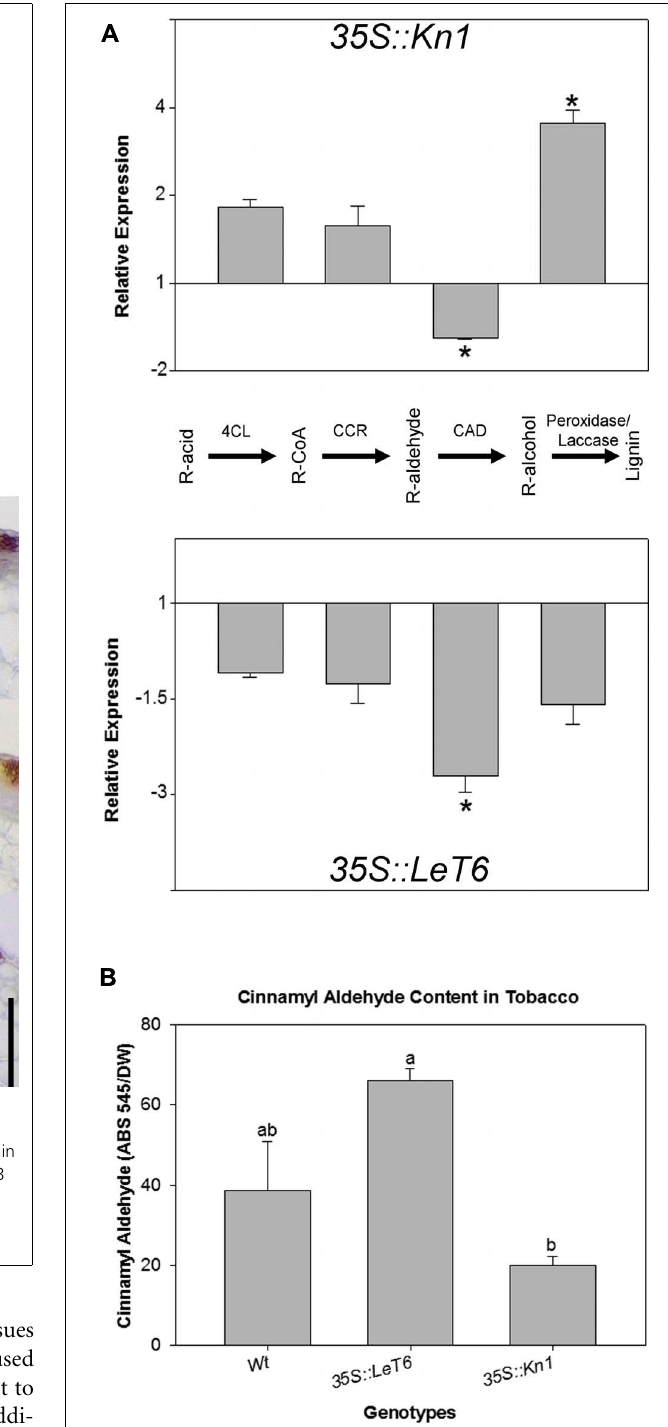
FIGURE 6 | (A) Relative expression of four key lignin biosynthetic genes [ 4CL ( 4-coumarate:CoA ligase 1 ), CCR ( cinnamoyl CoA reductase ), CAD (c innamyl alcohol dehydrogenase ), and PRX ( peroxidase ) R(lignin monomer functional group)] in 35S::Kn1 and 35S::LeT6 tobacco plants. (B) Cinnamyl aldehyde moiety levels in wild-type (Wt), 35S::LeT6 , and 35S::Kn1 tobacco plants. Error bars represent standard error [ ± SE; N = 3 (A) , N = 4 (B) ], P = 0.009 (A) and P = 0.005 (B)